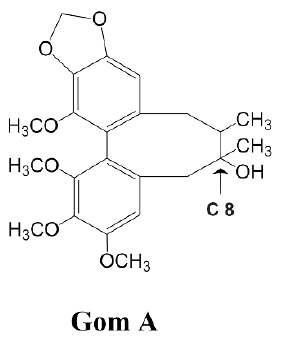
Figure 1. Chemical structure of Gom A.